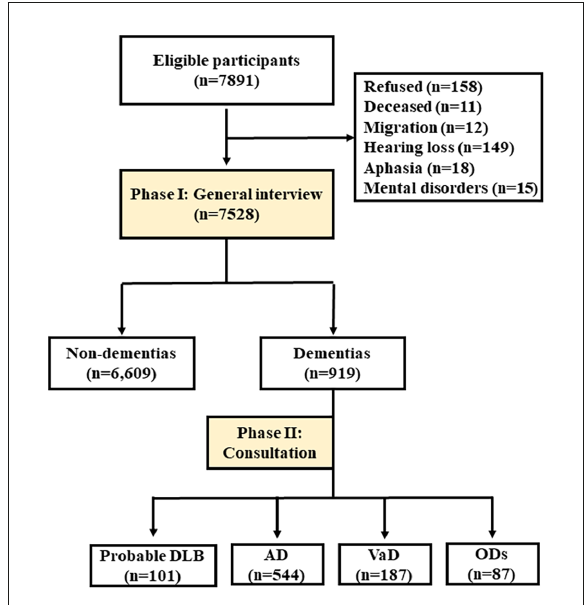
FIGURE1 Flow chart of this study. The flow chart of the survey with two phases was showed, to investigate the prevalence rates of dementia and its subtypes. DLB, dementia with Lewy bodies; AD, Alzheimer’s disease; VaD, vascular dementia; ODs, other